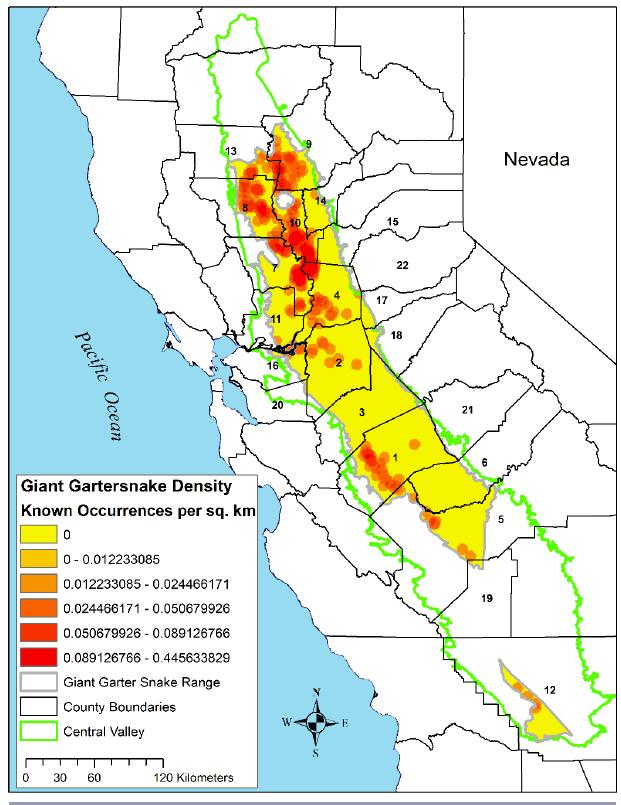
Fig. 1 . The geographic range of giant garter snake (GGS; Thamnophis gigas ) and the density of known GGS occurrences (derived from California Natural Diversity Database point data) within the Central Valley ecoregion of the state of California. Numbered counties correspond to Table 1 (the rank order of the percent of range within each respective